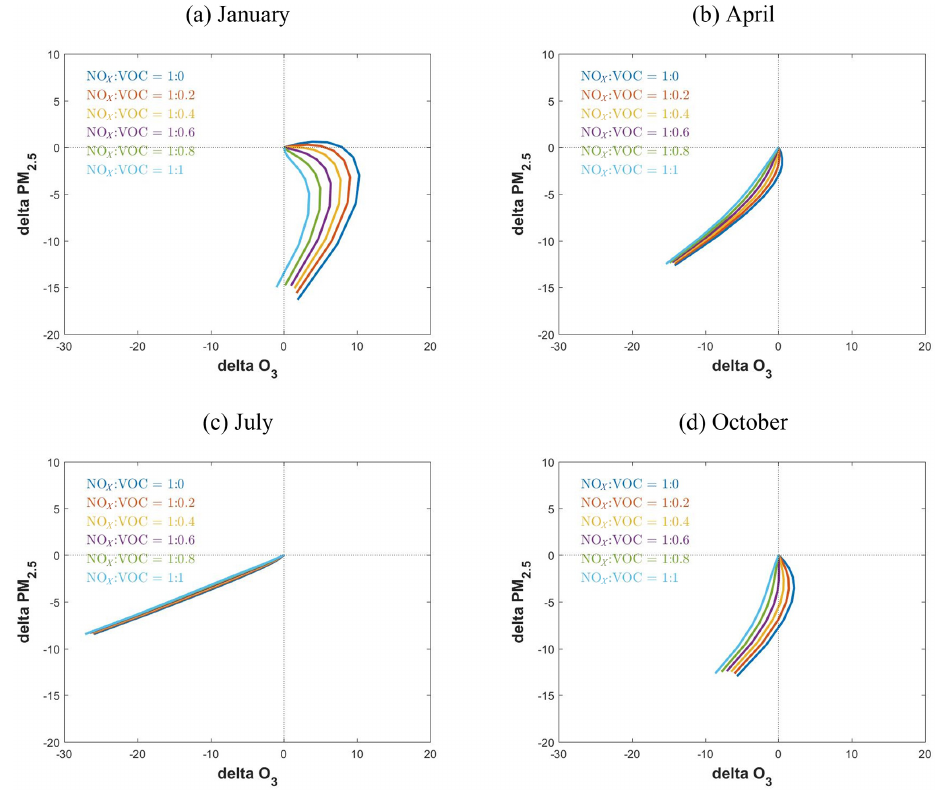
Figure 14. Control effectiveness with different NO x and VOC ratios in reducing population-weighted PM 2 . 5 and O 3 concentrations (µgm − 3 ) in China (NO x is from no control to 80%